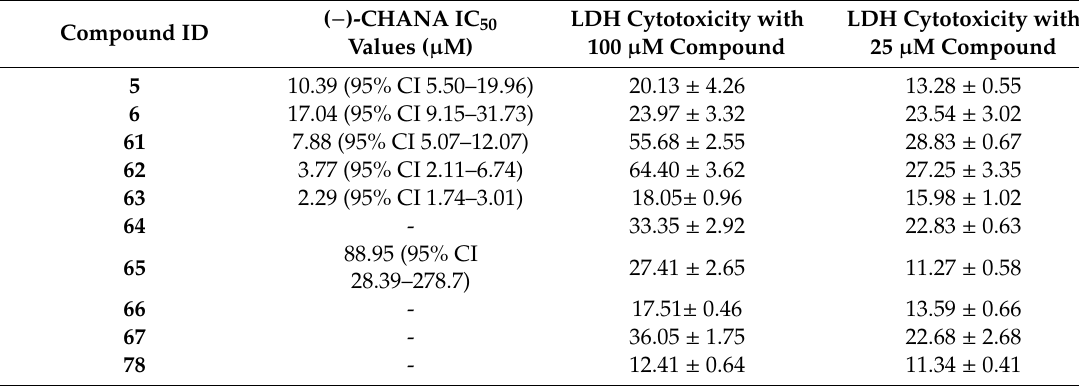
Table 6. Cellular cytotoxicity and potency testing in HEK293 mts17 β -HSD10